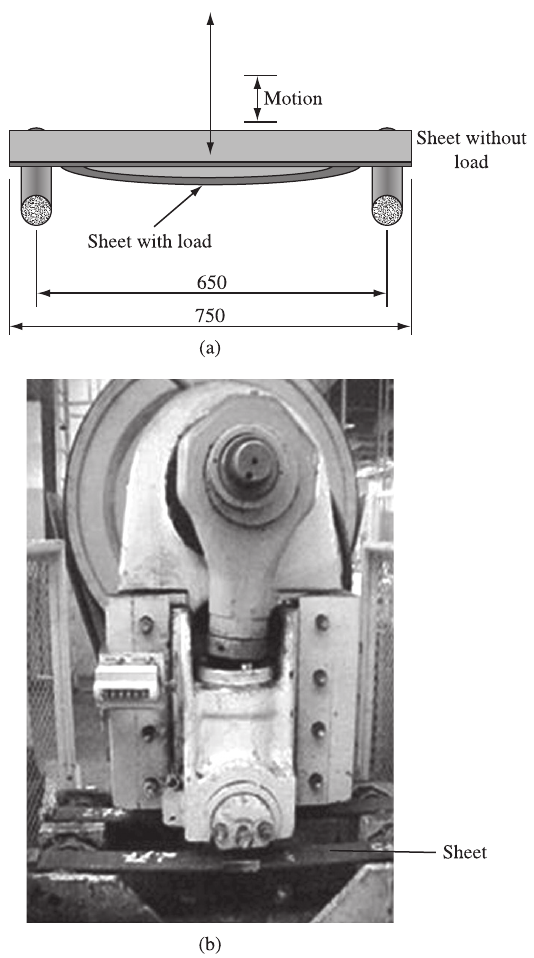
Figure 6. Schematic representation of the fatigue test. The dimensions are in